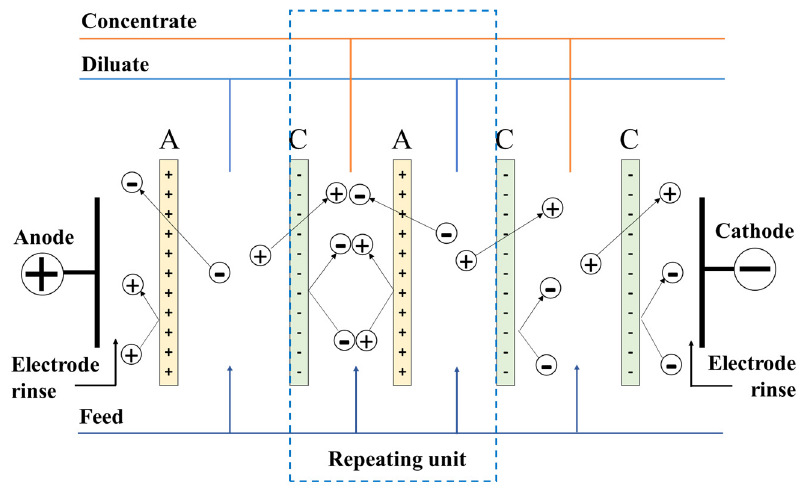
Figure 2. Schematic diagram of principles of classic electrodialysis.